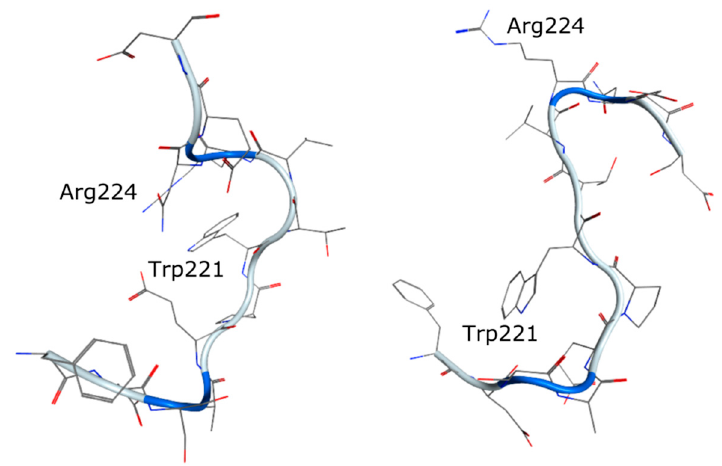
Figure 8. Structural comparison of the loop residues 216–227 in MMP-14. Left: bound to LEM-2/15 (PDB ID: 4P3D) [34] and right: the loop conformation of MMP-14 bound to TIMP-1 (PDB ID: 3MA2) [84]. The observed conformational change can explain the inhibition due to allosteric modification of the enzyme structure.